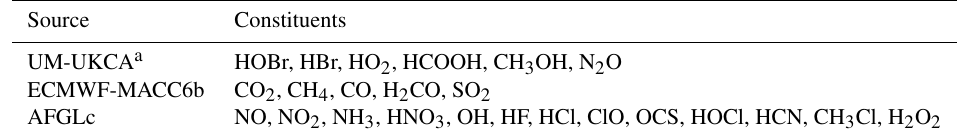
Table 3. Trace gases added to the background atmosphere (which includes H 2 O, O 3 , O 2 and N 2 ) and their climatological sources. Source